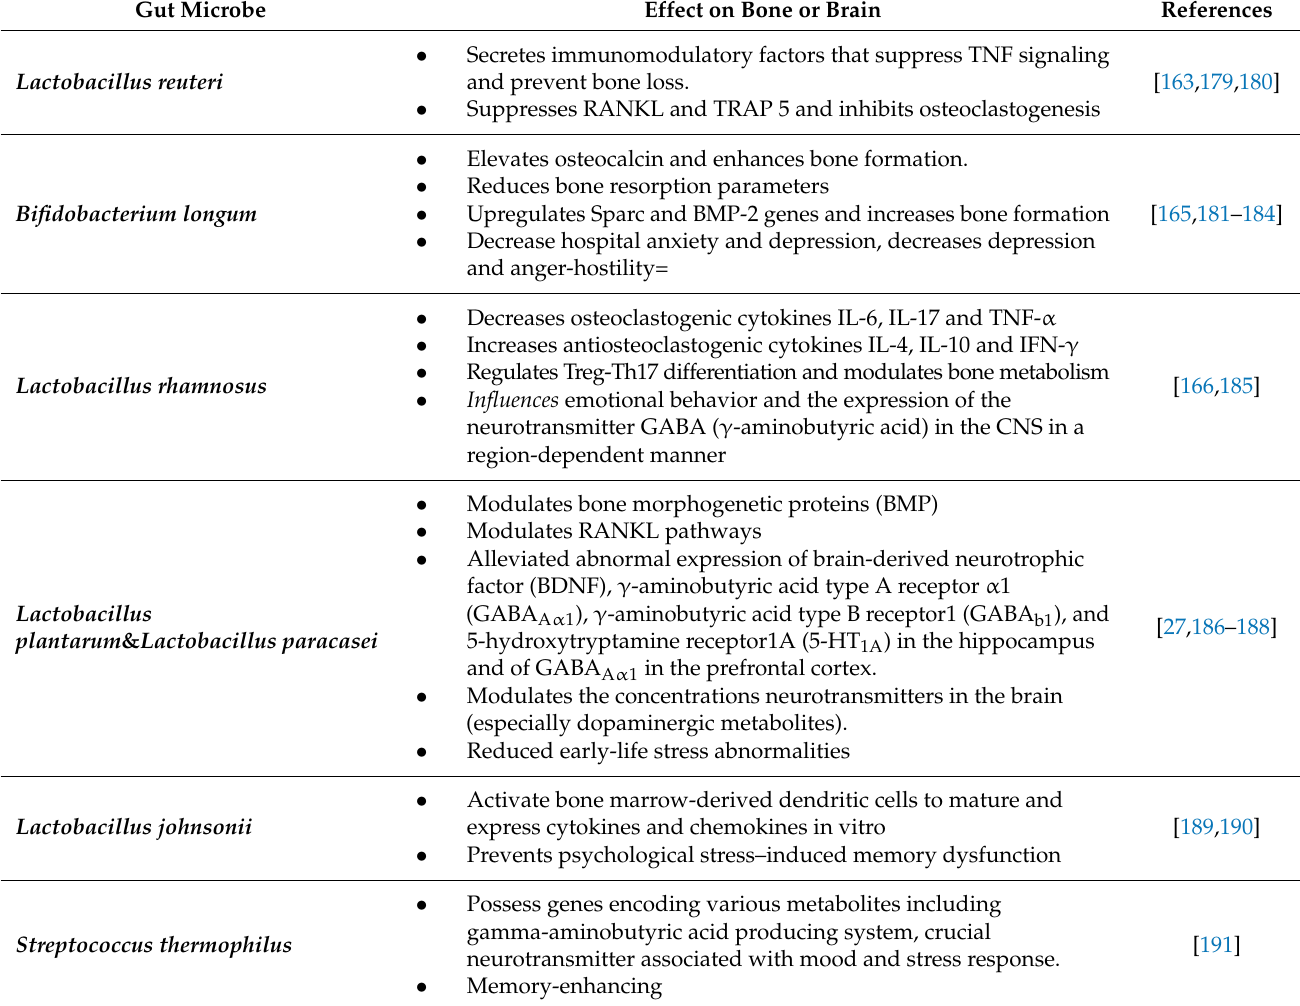
Table 2. Major gut microbes and their protective effects on bone and